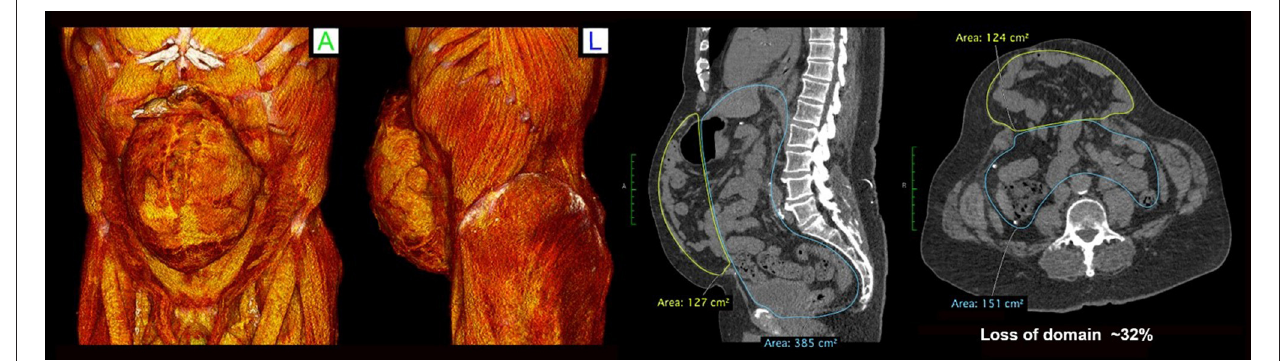
FIGURE 1 | Baseline CT images demonstrating large incisional hernia post 2 open AAA repairs and two subsequent open incisional hernia repairs. Loss of domain is calculated at